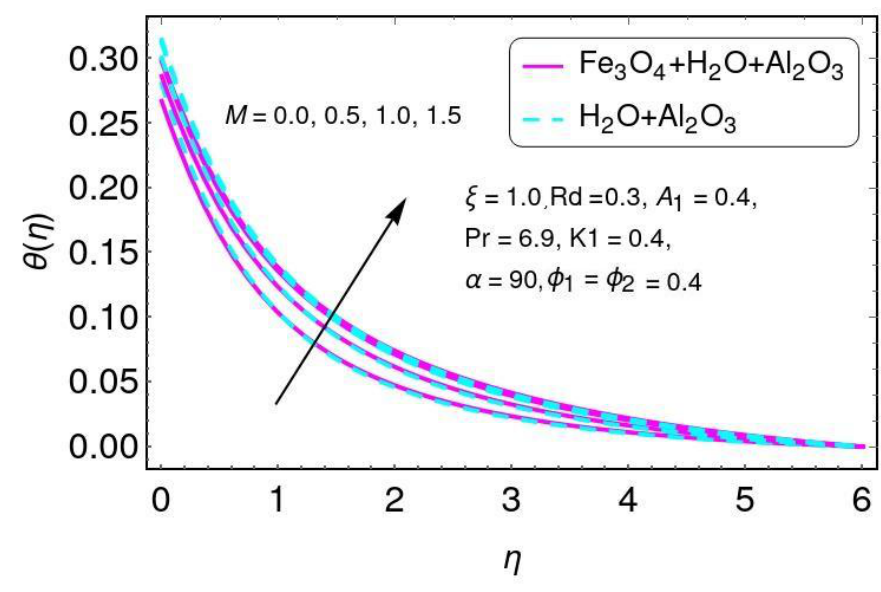
Figure 3. The result of M on θ ( η )